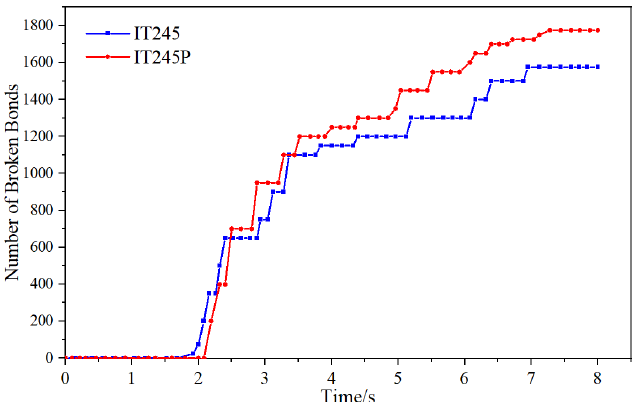
Figure 16. Comparison of broken bonds of Cyperus esculentus plants.